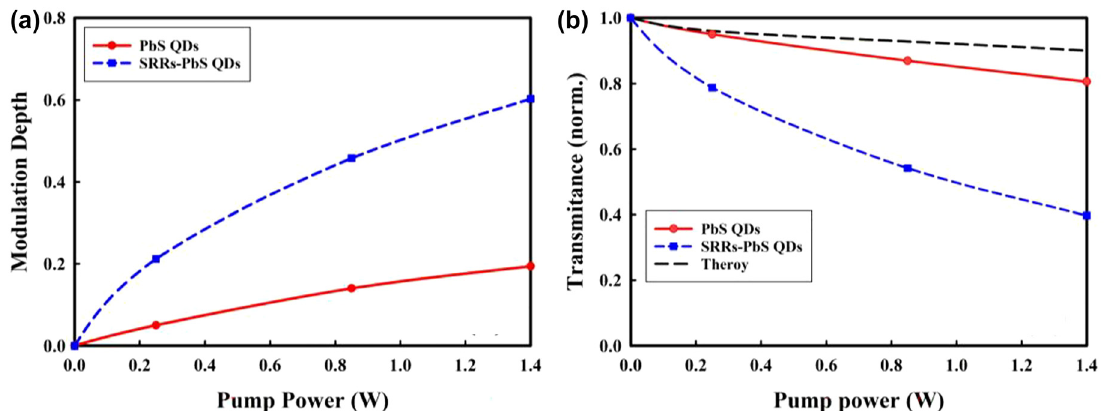
Figure 4: Optical modulation results. (a) MD and (b) normalized THz transmittance for devices with and without SRRs as a function of the pump